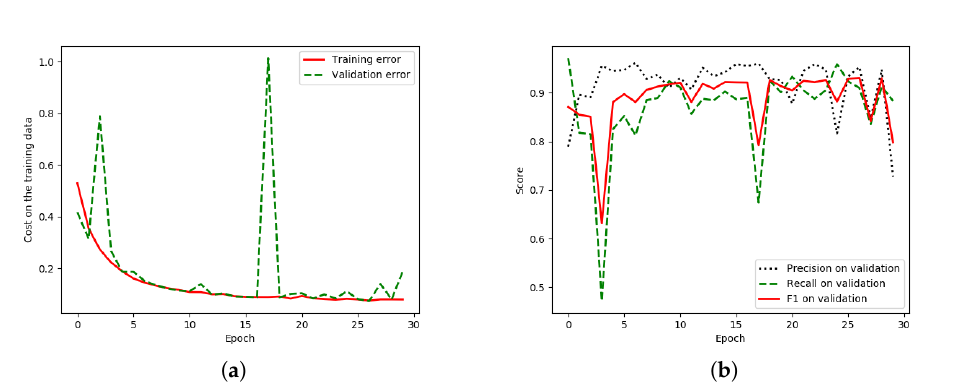
Figure 17. Graph (learning curves) on Landsat-8w5c data set of the baseline approach, GCN152-TL-A [12]; x refers to epochs, and y refers to different measures ( a ) Plot of model loss (cross-entropy) on training and validation corpora; ( b ) performance plot on the validation corpus.